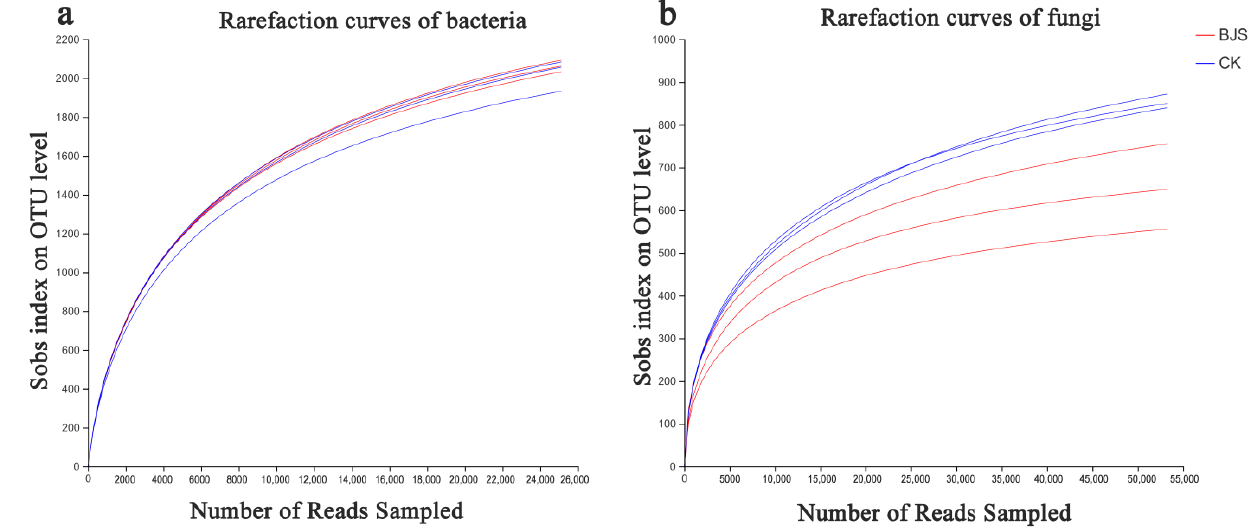
Figure 1. A rarefaction curve of bacterial communities ( a ) and a rarefaction curve of fungal commu- nities ( b ) showing the influence of a 3% dissimilarity cutoff on uncovered OTUs. “BJS-1-3” means BJS-1-3 fermentation-broth-treated poplar group; “CK” means sterilized fermentation-broth-treated poplar group. For each treatment, three replicates were analyzed.